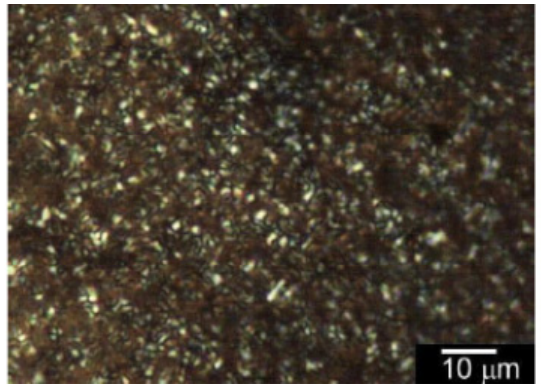
Figure 8. Polarizing optical microscopy (POM) images of polyITN-Pyr cast film from THF